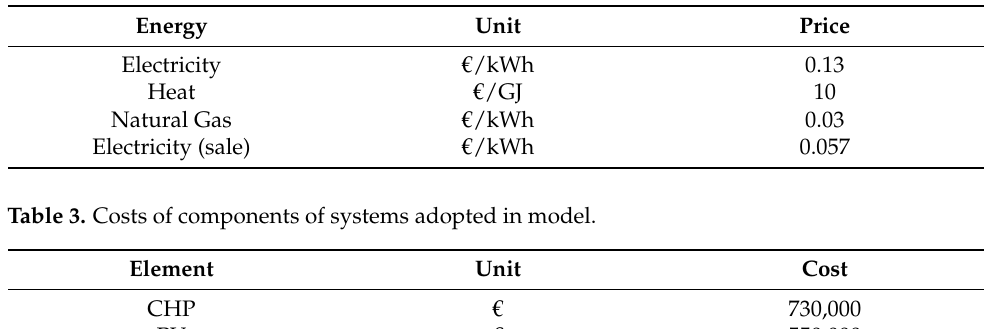
Table 2. Costs of energy adopted in model.